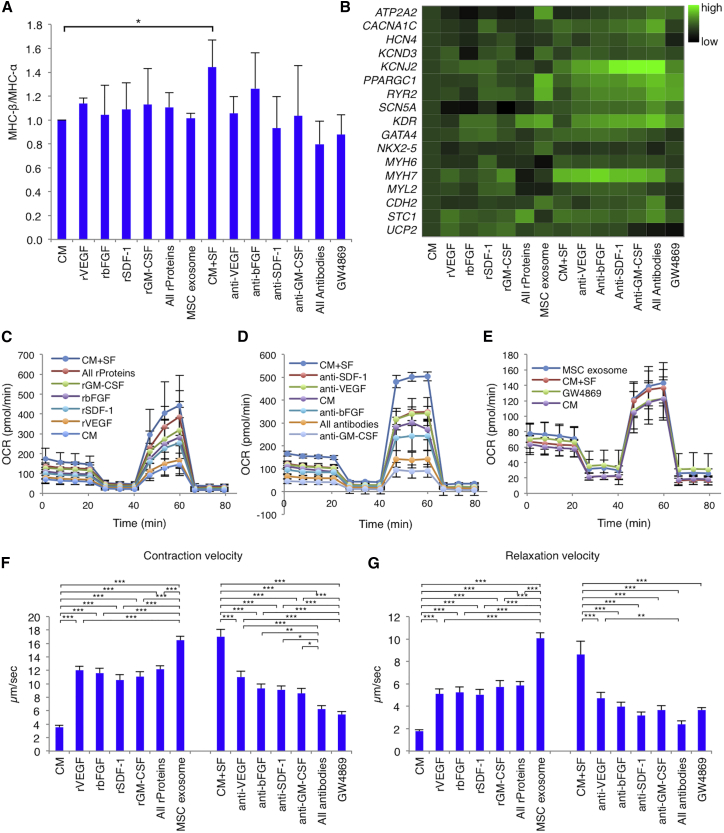
Impact of the Soluble Factors Derived from hMSCs on the Maturity of hiPSC-CMsRecombinant vascular endothelial growth factor (rVEGF), recombinant basic fibroblast growth factor (rbFGF), recombinant stromal cell-derived factor 1 (rSDF-1), recombinant granulocyte-macrophage colony-stimulating factor (rGM-CSF), all four recombinant proteins (all rProteins), or hMSC exosomes (MSC exosome) were added to culture media containing hiPSC-CMs (CM). Anti-VEGF neutralizing antibody (anti-VEGF), anti-bFGF neutralizing antibody (anti-bFGF), anti-SDF-1 neutralizing antibody (anti-SDF-1), anti-GM-CSF neutralizing antibody (anti-GM-CSF), all four neutralizing antibodies (all antibodies), or GW4879 were also added to culture media containing hiPSC-CMs with hMSC-derived soluble factors. (A) Ratio of myosin heavy chain (MHC)-β to MHC-α in all groups (n = 4 for each group). *p < 0.05, one-way ANOVA with post hoc Tukey’s HSD test. (B) Heatmap regarding expression of the cardiac genes in all groups, normalized against GAPDH expression (n = 9 for each group). (C) Representative mitochondrial respiration rates in the CM, rVEGF, rbFGF, rSDF-1, rGM-CSF, all rProteins, and CM+SF groups. (D) Representative mitochondrial respiration rates in the CM, anti-VEGF, anti-bFGF, anti-SDF-1, anti-GM-CSF, all antibodies, and CM+SF groups. (E) Representative mitochondrial respiration rates in the CM, MSC exosome, GW4879, and CM+SF groups. (F and G) Contraction velocity (F) or relaxation velocity (G) in all groups (n = 5 for each group). *p < 0.05; **p < 0.01; ***p < 0.001, one-way ANOVA with post hoc Tukey’s HSD test. For all experiments, results are shown as mean + SEM. OCR, oxygen consumption rate.